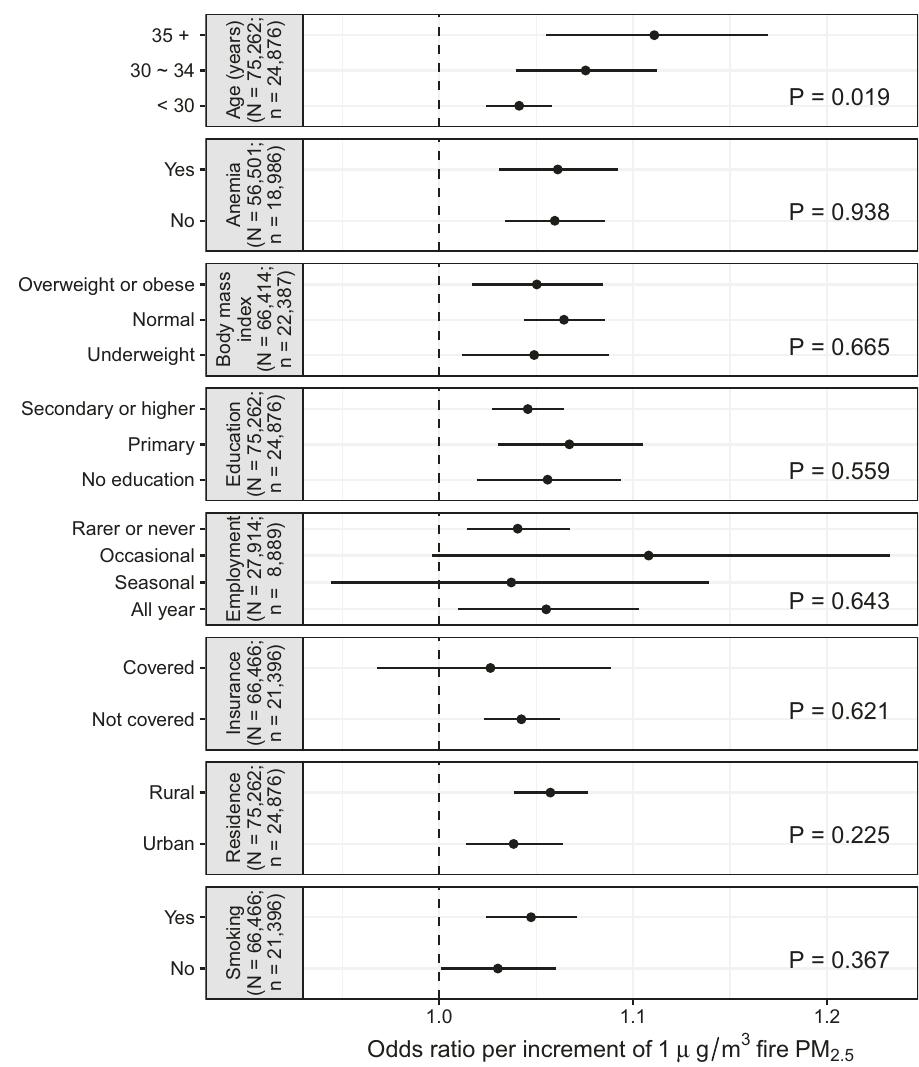
Fig. 2 Estimated associations between open fi re PM 2.5 and pregnancy loss by subpopulation. Concentrations of fi re PM 2.5 were assessed by the GEOS- Chem model, and the associations were adjusted by maternal age, temperature, humidity, temporal trends, and non- fi re PM 2.5 . Along y -axis, “ n ” denotes the number of mothers, and “ N ” denotes the size of total samples (i.e., cases and controls). In each panel, “ P ” presents the likelihood-ratio Chi-squared test P -value for an alternative hypothesis that the estimated associations are different between subgroups classi fi ed by a subpopulation indicator. Each group of estimates is derived from an individual model of “ n ” independent pairs of cases and controls. The dots denote point-estimates of the associations, and the error bars denote the corresponding 95% con fi dence intervals. PM 2.5 particulate matter with a diameter of less than 2.5 µ